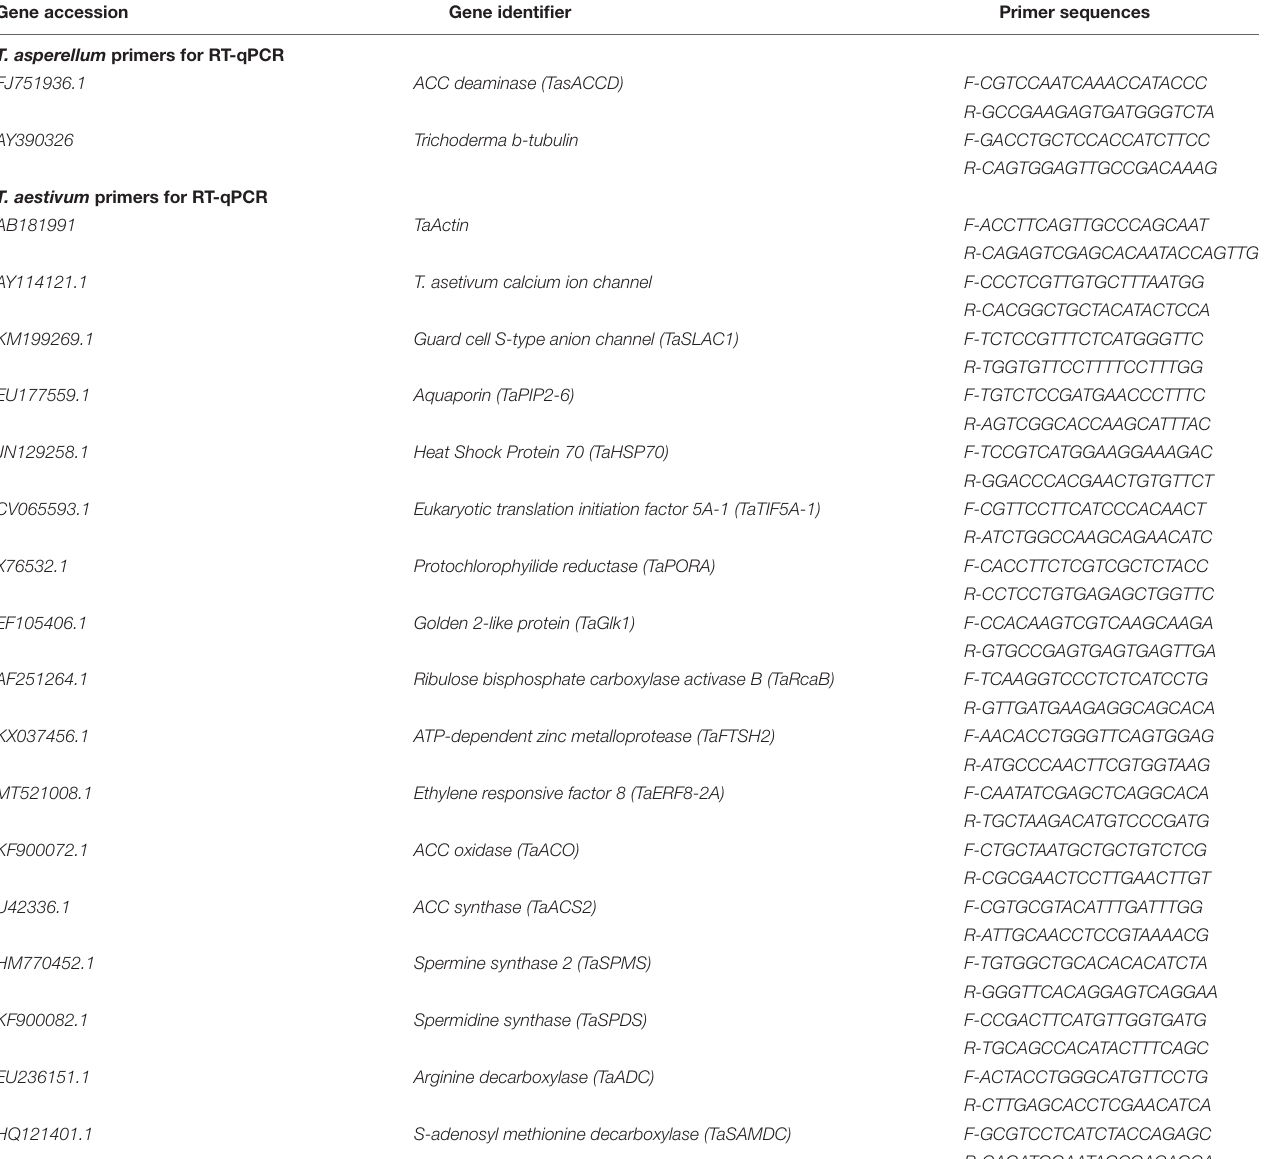
TABLE 1 | Primers used for RT-qPCR